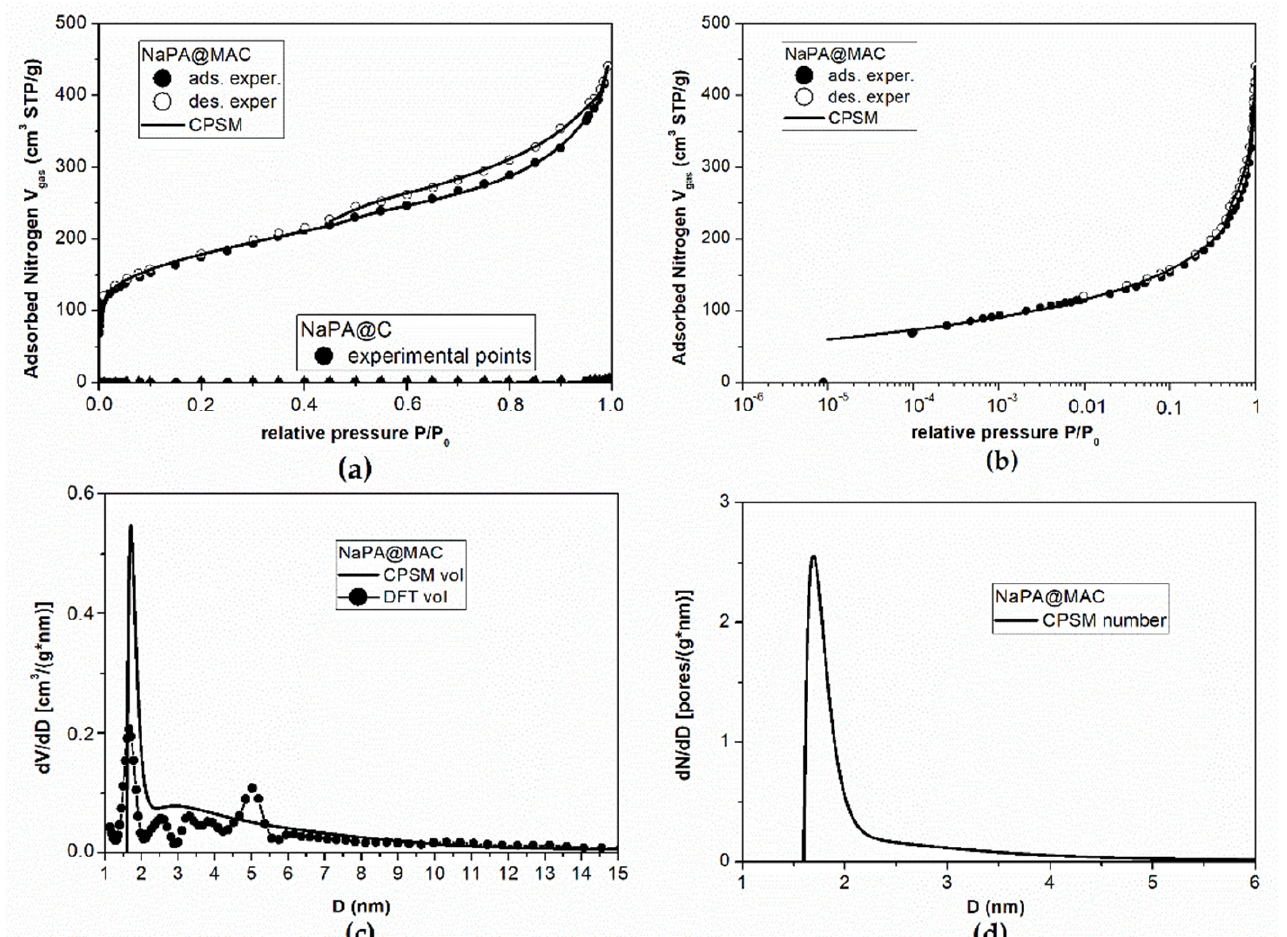
Figure 5. Simulation and results of nitrogen porosimetry experimental data for NaPA@MAC and NaPA@C materials. CPSM model fitting (continuous line) over all the experimental adsorption (black points) and desorption (white points) data ( a ) higher relative pressure hysteresis loop for the material prepared with NaPA@MAC and without magnetic iron particles NaPA@C ( b ) lower relative pressure hysteresis loop for NaPA@MAC. ( c ) Pore volume distribution according to the DFT (black points) and to the CPSM (black line) for NaPA@MAC. ( d ) Pore number (population) distribution according to the CPSM model for